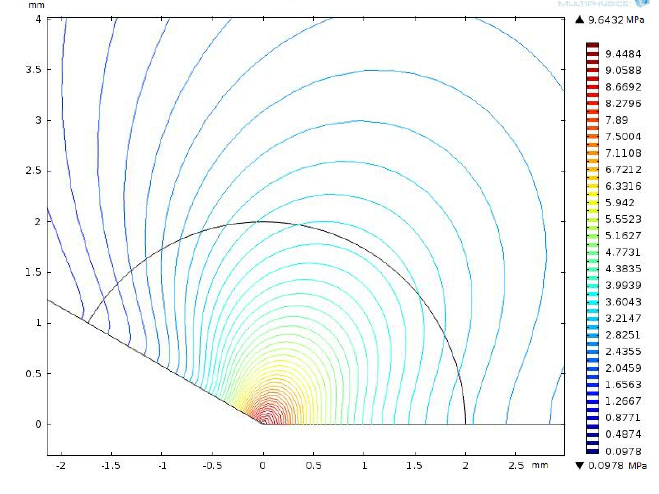
Figure 2: Example of plot of the σ eff,IG